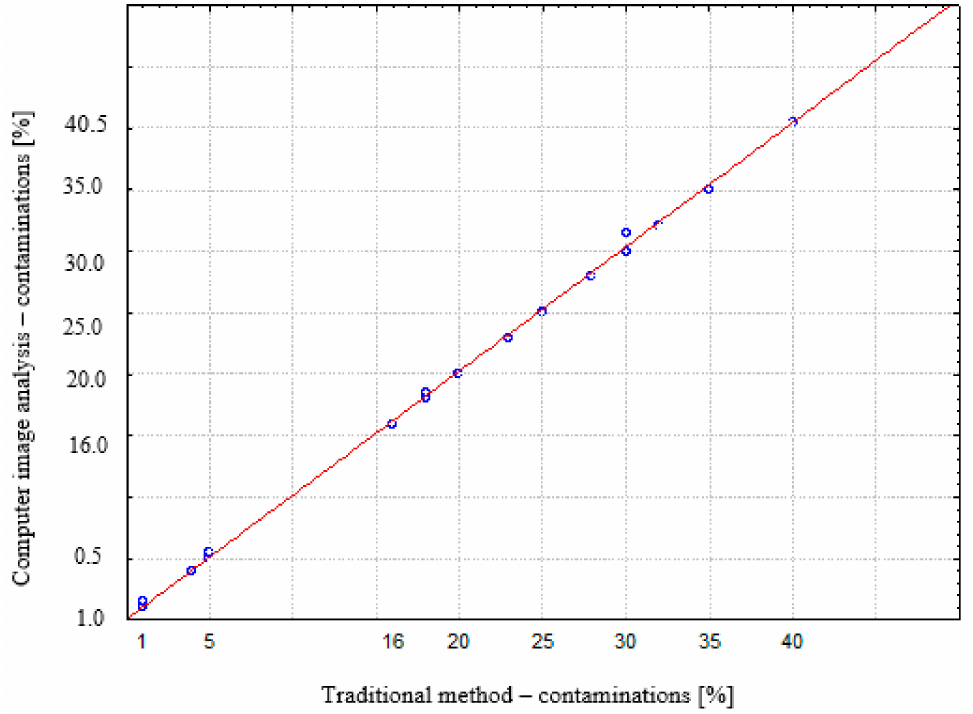
Figure 7. The graph of fitting of empirical data of percentage of contaminants in wheat seeds obtained by means of image analysis with empirical data obtained by traditional method (by weight—sieve) [own